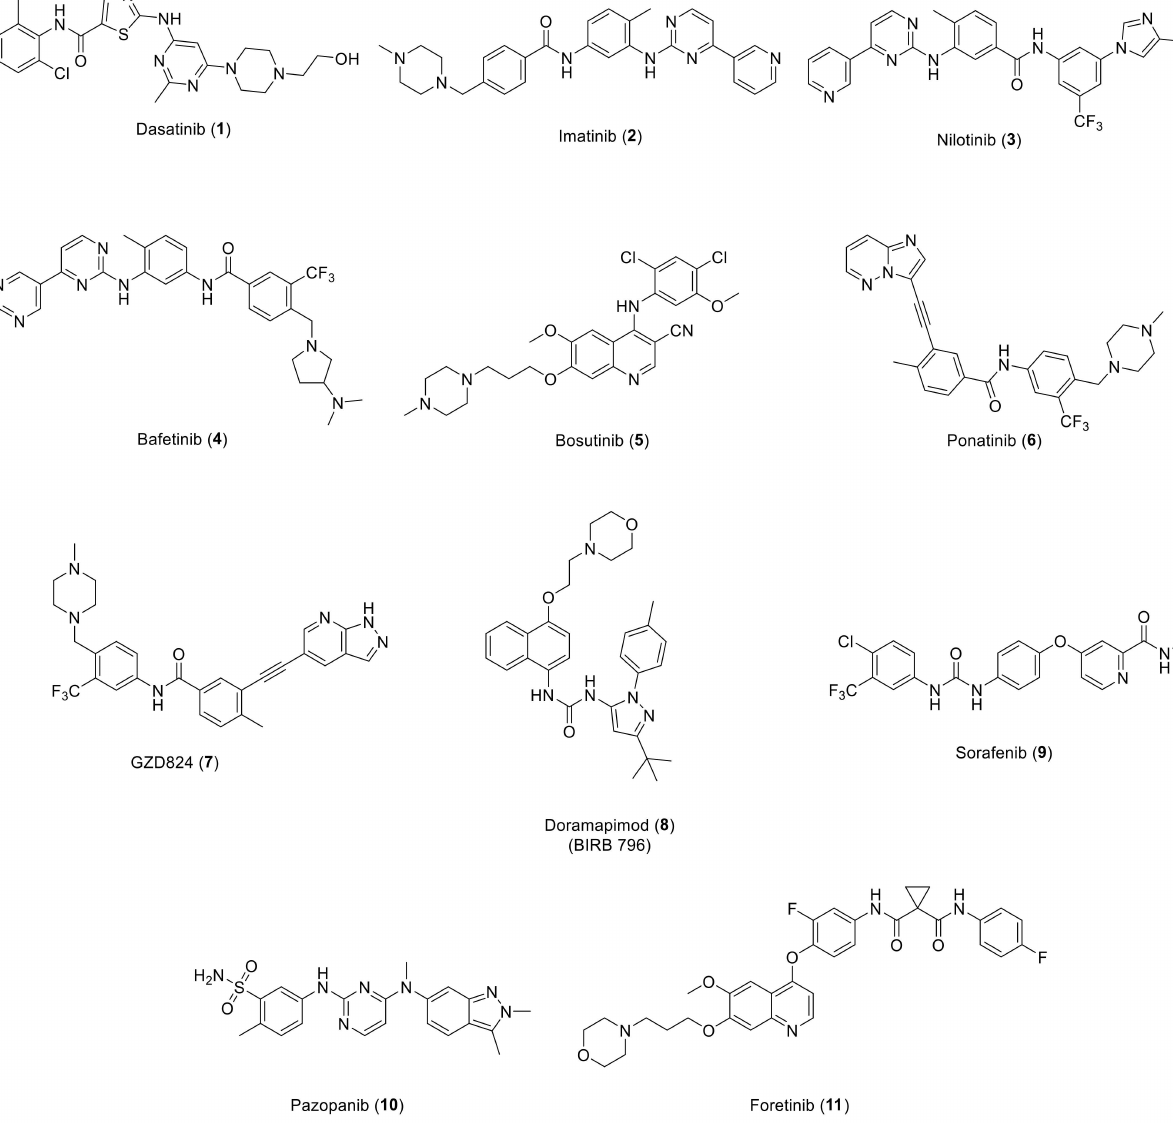
Figure 2. Chemical structures of compounds 1 – 11 .